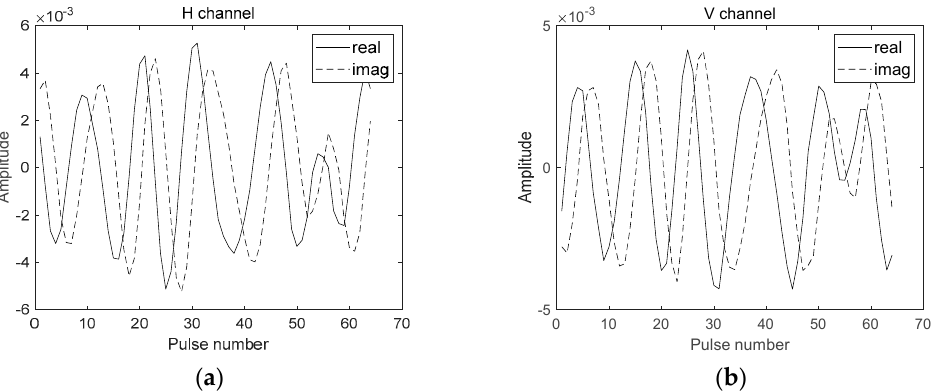
Figure 4. Simulation signal. ( a ) The real and imaginary parts of H − channel echo signal; ( b ) the real and imaginary parts of V − channel echo signal.